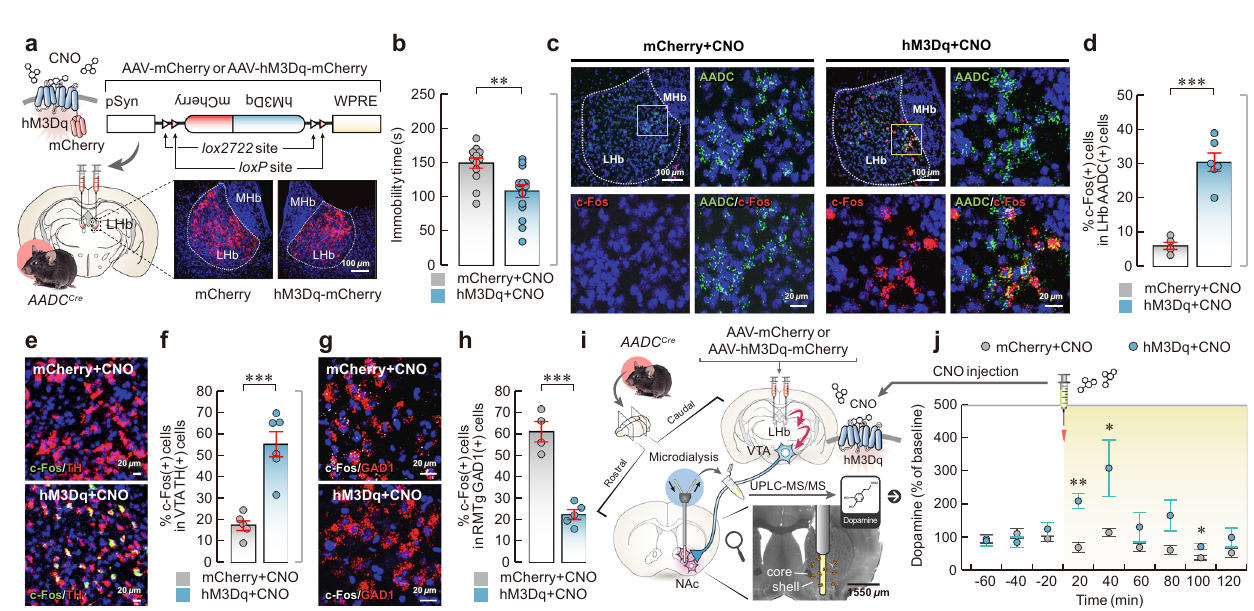
Fig. 2 | Chemogenetic stimulation of LHb D-neurons regulates dopamine secretion. a Schematic of AAV vectors for Cre-dependent hM3Dq or mCherry expression;representativeimagesofthelocationofviralinjection. b EffectofCNO- induced activation of LHb D-neurons on behaviour observed in the TST as mea- sured by immobility time ( n =14 independent mCherry mice and n =15 indepen- dent hM3Dq mice). c – h Changes in the expression of c-Fos in VTA dopaminergic neurons and RMTg GABAergic neurons caused by chemogenetic stimulation of LHbD-neurons.RepresentativeFISHimagesintheLHbandmedialhabenula(MHb) ( c ) and the percentage of c-Fos-expressing AADC-positive neurons in the LHb by FISH ( n =5 independent mCherry mice and n =6 independent hM3Dq mice) ( d ). Expression of c-Fos/TH in the VTA ( e ) and c-Fos/GAD1 in the RMTg ( g ) by FISH. Percentage of c-Fos-expressing TH-positive neurons in the VTA ( n =5 independent